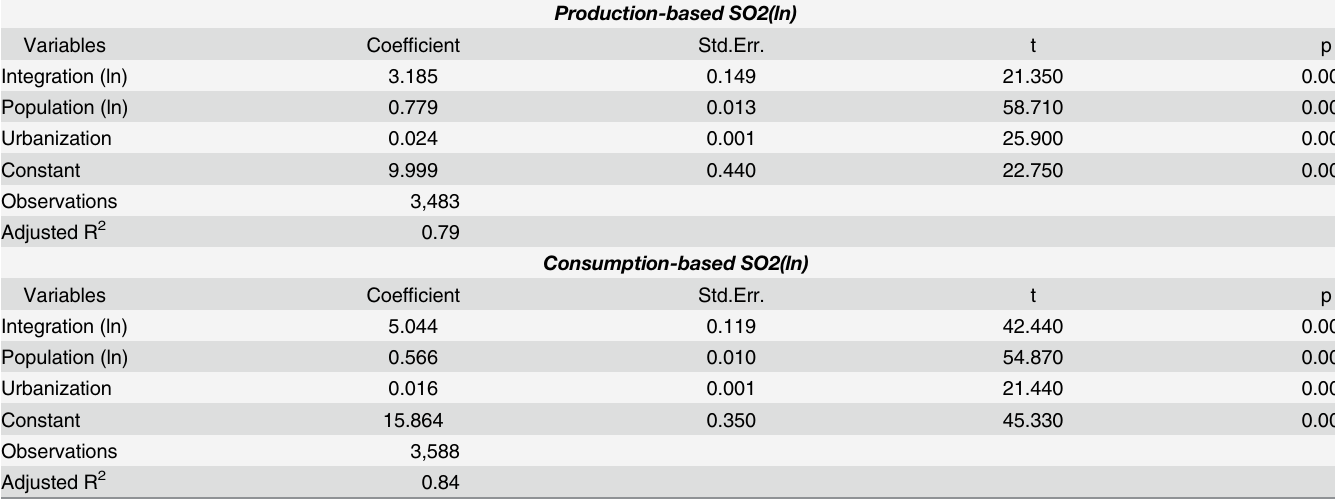
Table 5. Stepwise Regression Results for Two Forms of